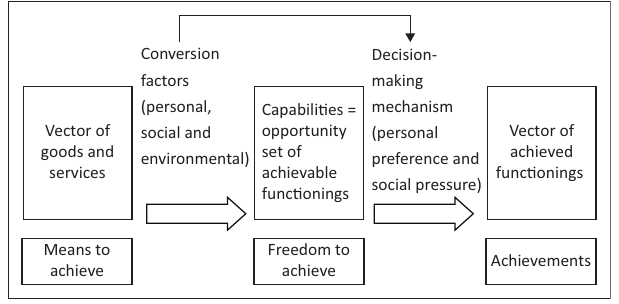
FIGURE 1: Capability approach.